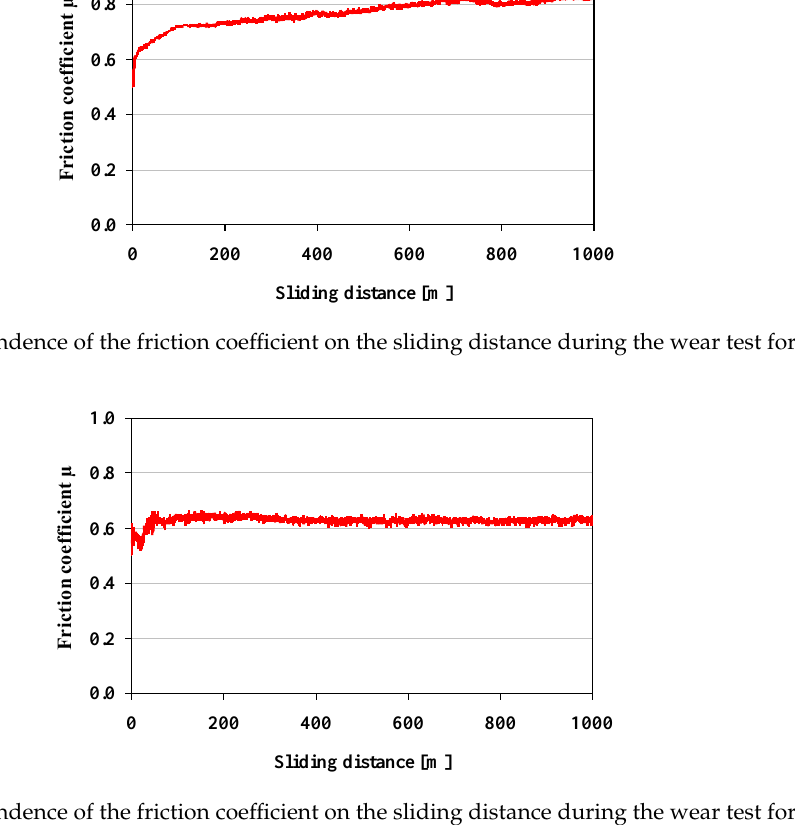
Table 3. The average value of the friction coefficient and the weight loss of tested coatings.